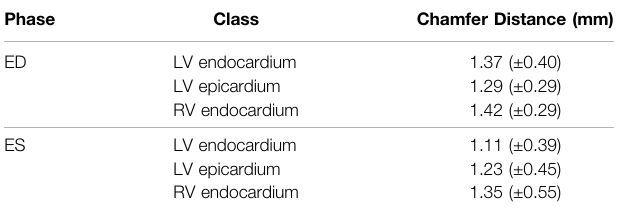
TABLE 1 | ECG reconstruction results of multiple methods on different datasets. Method